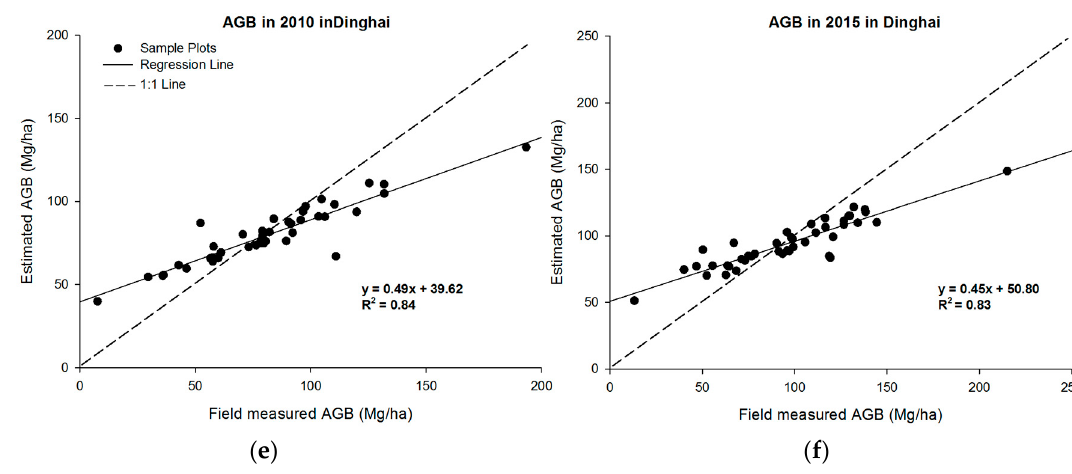
( e ) ( f ) Figure 5. The relationship between estimated and field-measured AGB in three regions: ( a ) AGB in 2010 in Wuyi; ( b ) AGB in 2015 in Wuyi; ( c ) AGB in 2010 in Xianju; ( d ) AGB in 2015 in Xianju; ( e ) AGB in 2010 in Dinghai; ( f ) AGB in 2015 in Dinghai.